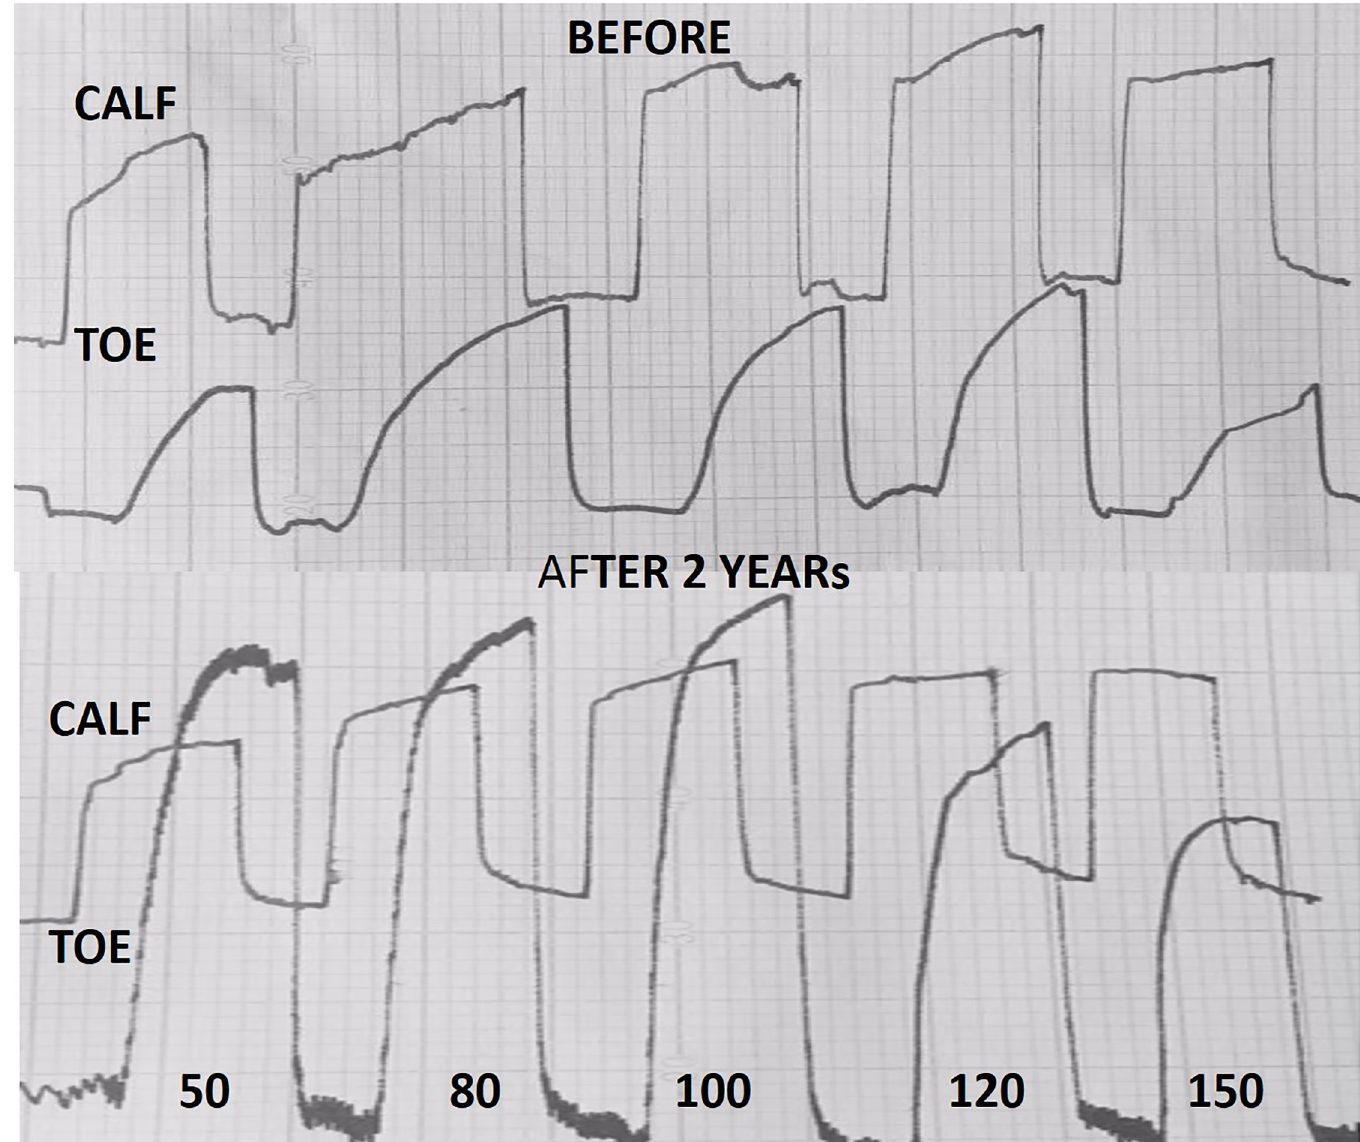
Fig 11. Calf and big toe plethysmography before and after 2 years of daily use of our arterial assist pump in a patient with calf multifocal arterial occlusions. The peak levels of calf arterial inflow do not show major difference before and after therapy. The peak levels of big toe inflow evidently higher than before therapy. Note no stop to arterial capillary flow at venous occlusion pressure of 150